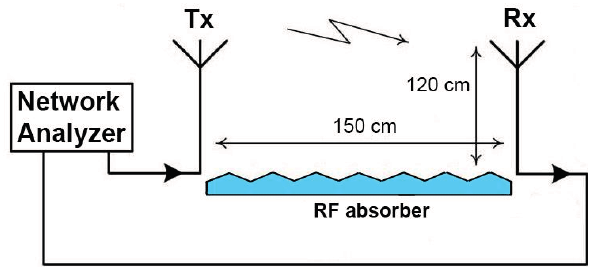
Figure 9. Schematic of the antenna gain measurements setup. Two antennas are mounted on bases, oriented in the direction of the maximum transmitted signal and connected to a network analyzer, and then are used for line-of-sight transmission in an unobstructed lab environment. RF absorber is placed on the ground in order to avoid multipath